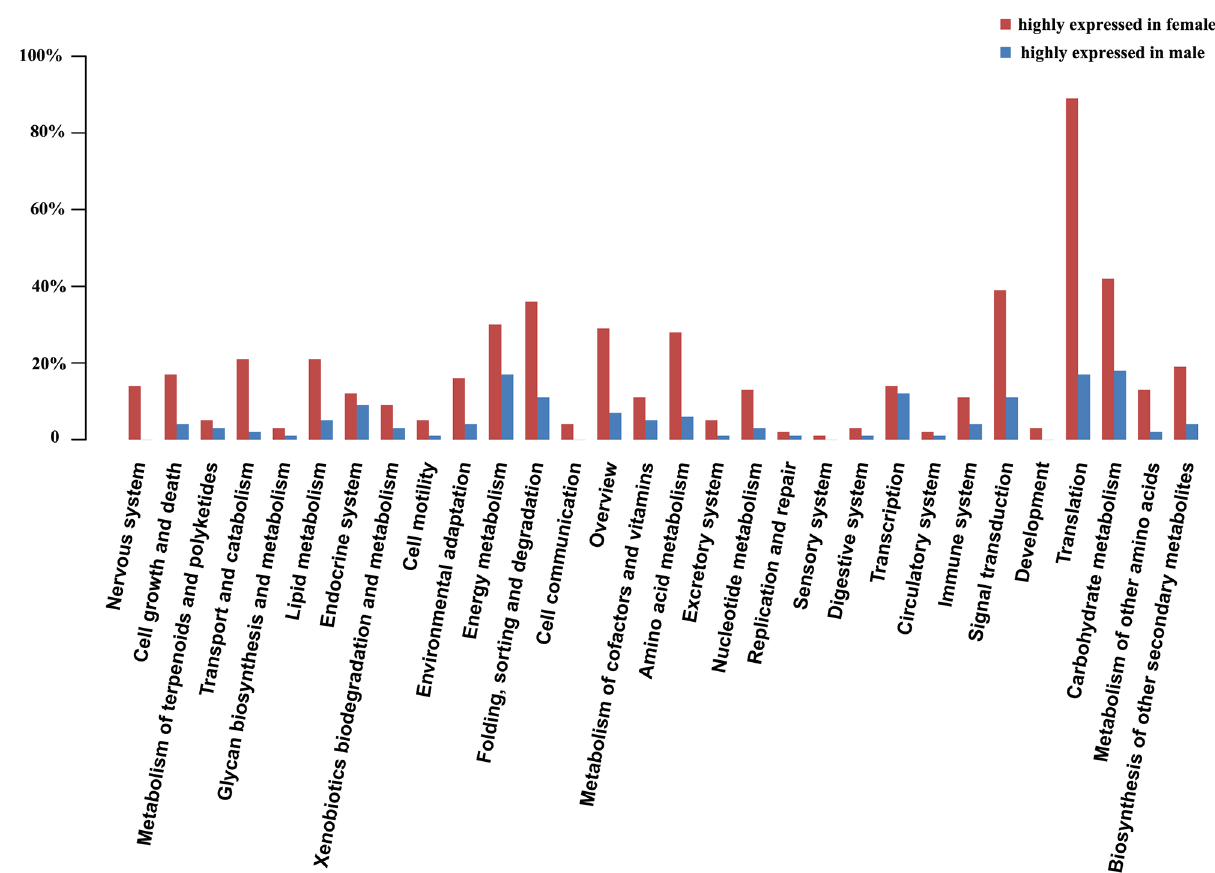
Fig 2. KEGG analysis for genes differentially expressedbetween female and male